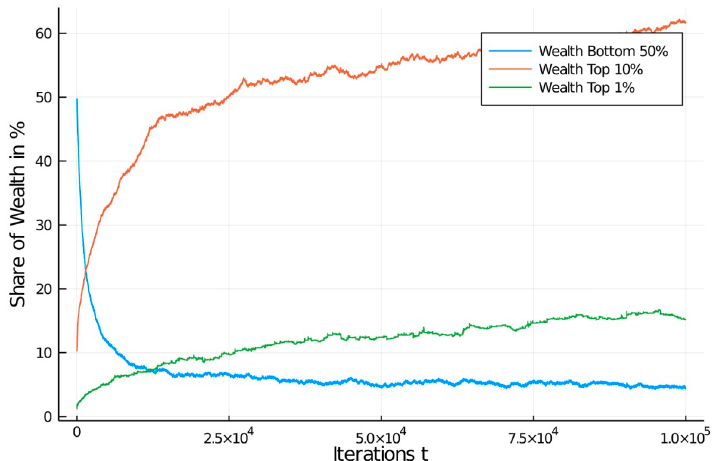
Fig 8. Progressive income tax. Wealth development in different quantiles of the population of 1,000 agents. Progressive income tax regime, with tax rate of between 15% and 45%, linearly growing in the income interval from $150 to $850. Initial distribution was equal among all 1,000 agents. Quantiles shown: Bottom half of the population vs top 10% and top 1% wealthiest agents.